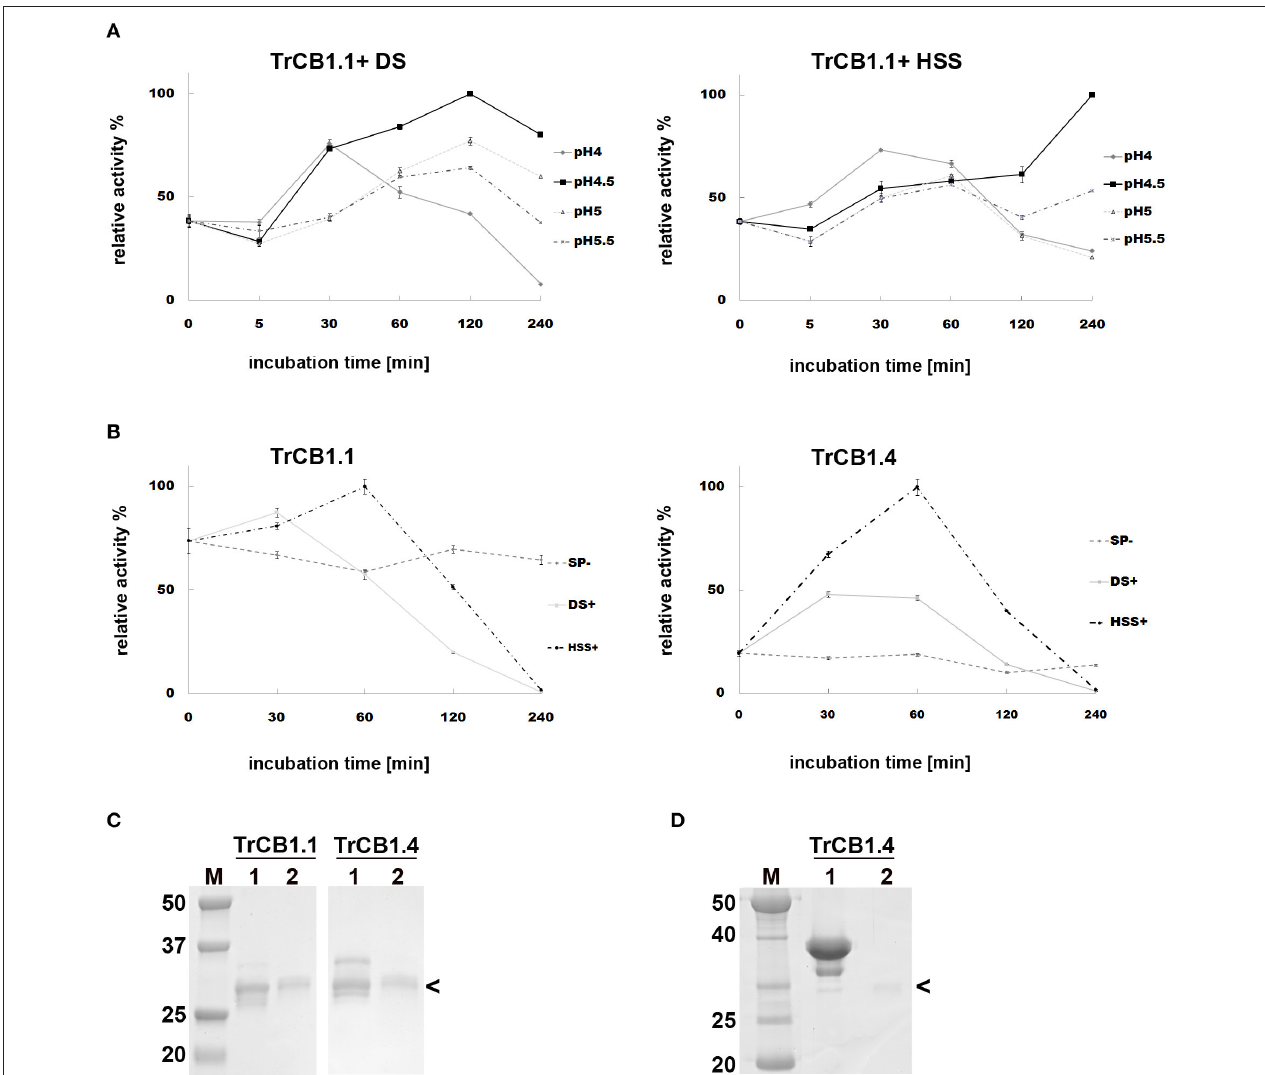
FIGURE 1 | Effect of sulfated polysaccharides on the autocatalytic activation of pro-TrCB1.1 and pro-TrCB1.4. Peptidolytic activities of TrCB1 forms generated after activation were determined in a kinetic assay with Z-Phe-Arg-AMC. The mean values ± standard deviation (SD) of two triplicate assays are expressed as percentage of relative activity in the sample at specified time points. (A) pro-TrCB1.1 was incubated in the presence of 10 µ g/ml dextran sulfate (DS) or heparin sodium salt (HSS) at various pH values. (B) pro-TrCB1.1 and pro-TrCB1.4 were incubated at pH 4.5 in the presence or absence of 20 µ g/ml sulfated polysaccharides (SP). (C) SDS-PAGE of (pro-)TrCB1.1 and (pro-)TrCB1.4 incubated in the presence of 10 µ g/ml DS at pH 4.5 for 30min (lanes 2). Lanes 1 contain the pro-enzyme without DS. (D) SDS-PAGE of (pro-)TrCB1.4 incubated in the presence of 10 µ g/ml HSS at pH 4.5 for 30min (lane 2). Lane 1 contains the pro-enzyme without HSS.